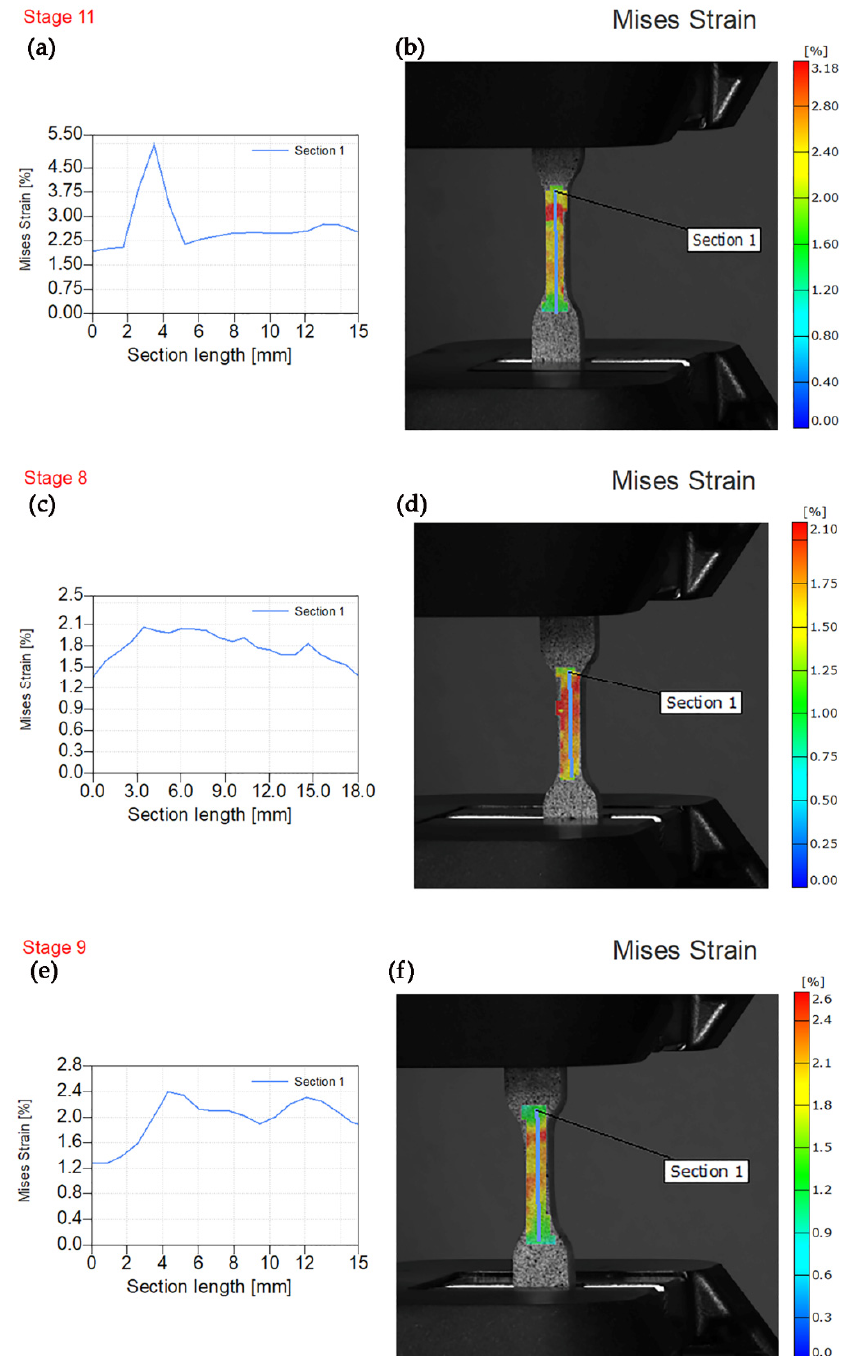
Figure 12. Experimental von Mises strain before fracture. ( a ) Von Mises strain—section length for PE/1W. ( b ) Sample image PE/1W with the overlaying von Mises strain field. ( c ) Von Mises strain—section length for PE/2W. ( d ) Sample image PE/2W with the overlaying von Mises strain field. ( e ) Von Mises strain—section length for PE/3W. ( f ) Sample image PE/3W with the overlaying von Mises strain